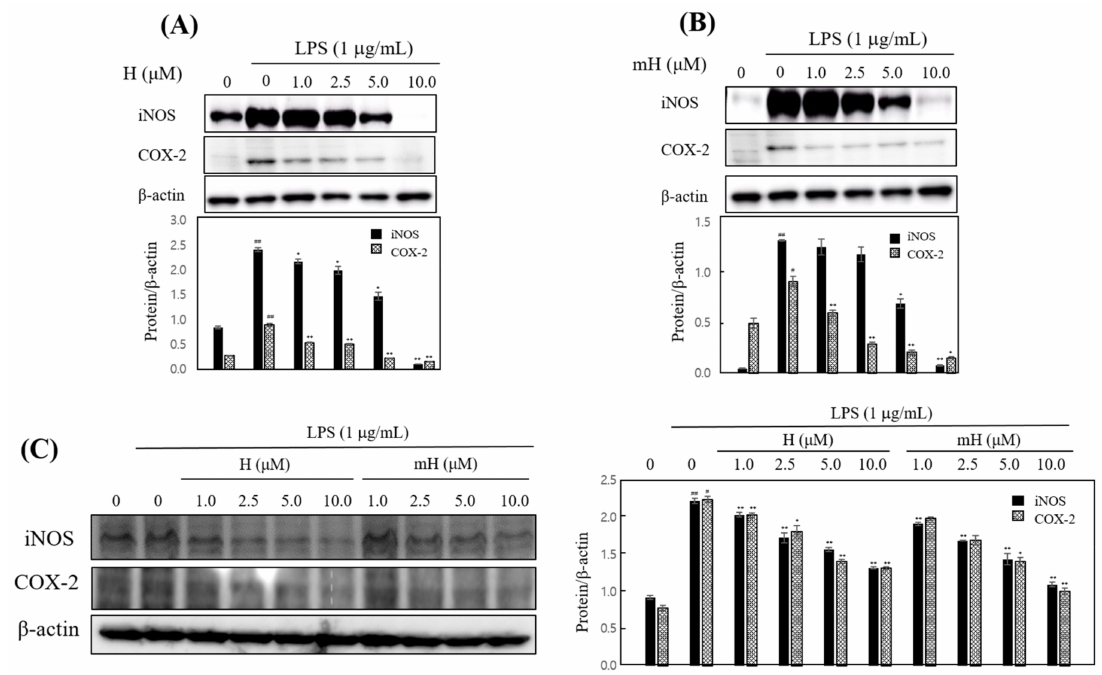
Figure 5. Effects of H and mH on inducible NO synthase (iNOS) and cyclooxygenase (COX)-2 expression. Cells were cultured in the presence of H and mH for 1 h and stimulated with LPS (1 µ g/mL) for 24 h under serum-free conditions. The expression of iNOS, COX-2, and β -actin in LPS-induced RAW 264.7 ( A , B ) and HT-29 cells ( C ) was detected by Western blot analysis. The relative density was calculated as the ratio of each protein expression to β -actin. # p < 0.05, ## p < 0.01 vs. control; * p < 0.05, ** p < 0.01 vs. LPS-treated